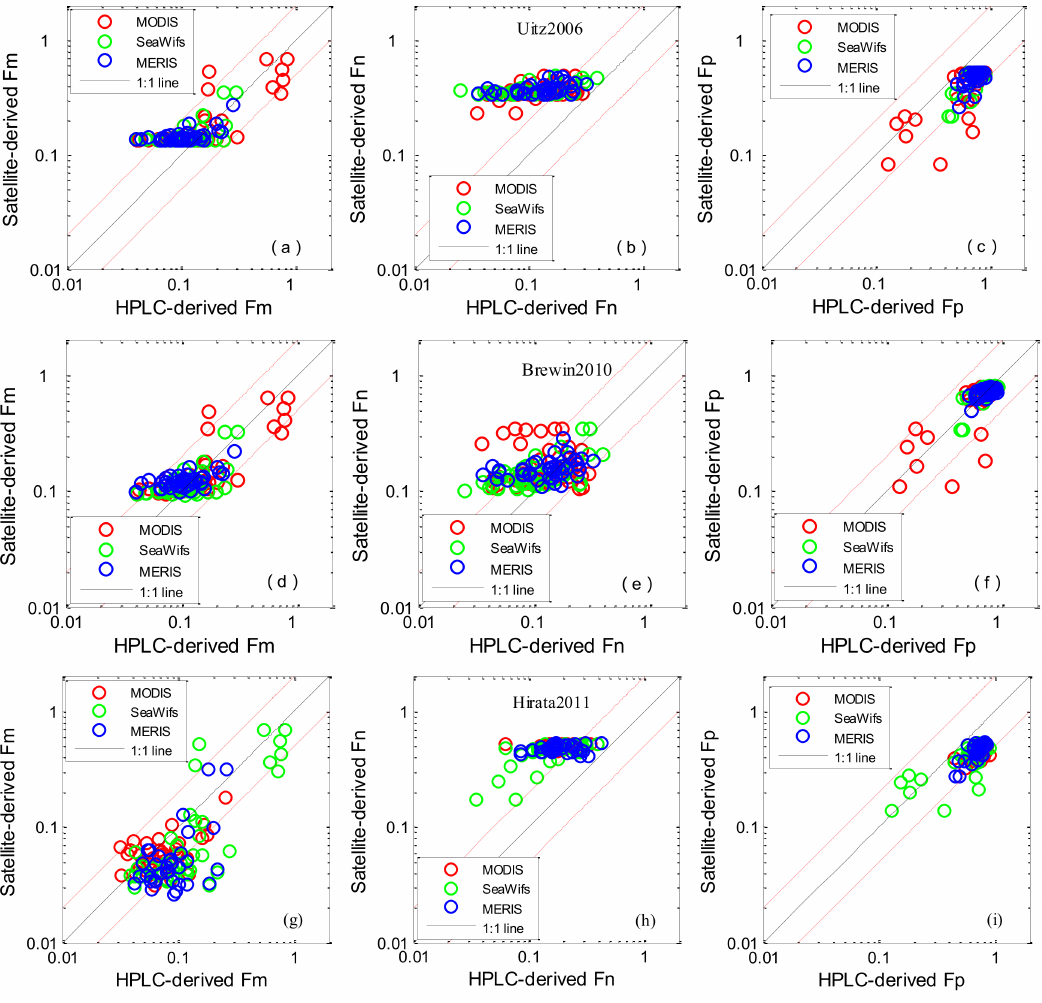
Figure 5. Scatter plots of satellite-derived PSCs versus in situ measurements: Uitz2006 ( a – c ); Brewin2010 ( d – f ); Hirata2011 ( g – i ). The solid line is the 1:1 line. The red dashed lines are the 1:2 and 2:1